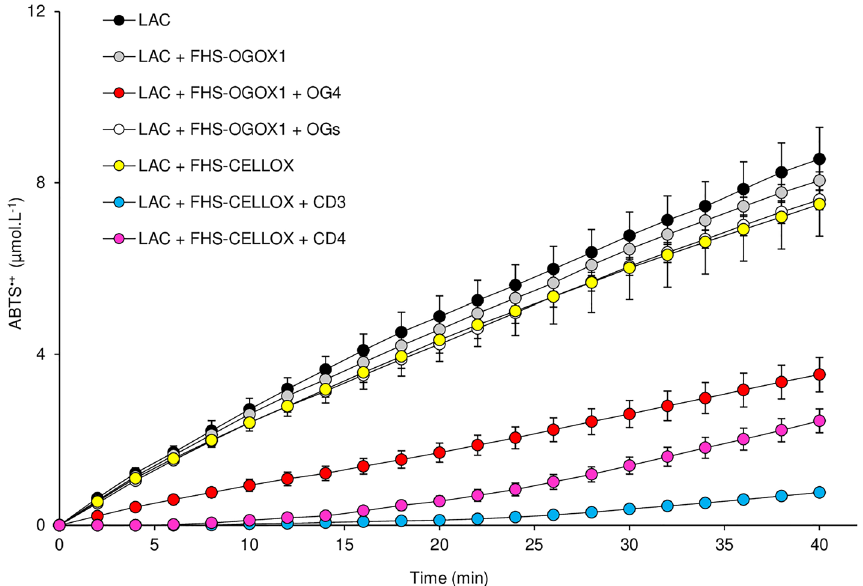
Figure 4. The activity of FHS-OSOXs on short oligosaccharides counteracts the laccase-catalyzed oxidation of ABTS. Production of ABTS ·+ (µmol.L −1 ) over time at pH 5.0 by laccase from T. versicolor alone (5 µg.mL −1 ) and in the presence of FHS-OGOX1 (4 nM) and two different galacturonic acid oligomers (OG4 and OGs) (15 µM), and of FHS-CELLOX (16 nM) and two different cellodextrins (CD3 and CD4) (15 µM). The enzymatic reaction also included ABTS (100 µM). Laccase activity was not affected in the only presence of oligomers (not shown). Values are mean ± SD (N = 3). [ ABTS 2,2’-azino-bis (3-ethylbenzothiazoline-6-sulfonic acid), CD3 cellotriose, CD4 cellotetraose, FHS-CELLOX flag-his-sumoylated cellodextrin-oxidase, FHS-OGOX1 flag-his-sumoylated oligogalacturonide-oxidase 1, LAC laccase from T. versicolor , OGs oligogalacturonides, OG4 tetra-galacturonic